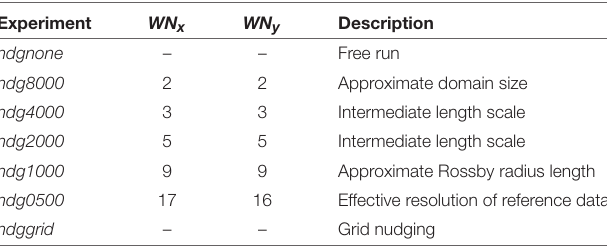
TABLE 2 | Wave numbers used in spectral nudging options for all experiments in both x and y direction and the associated lengths, in km.